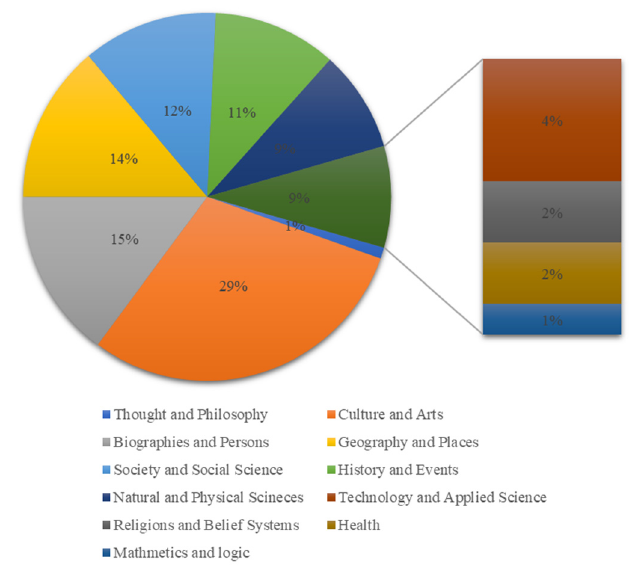
Figure 6. The English Wikipedia content by subject [25].